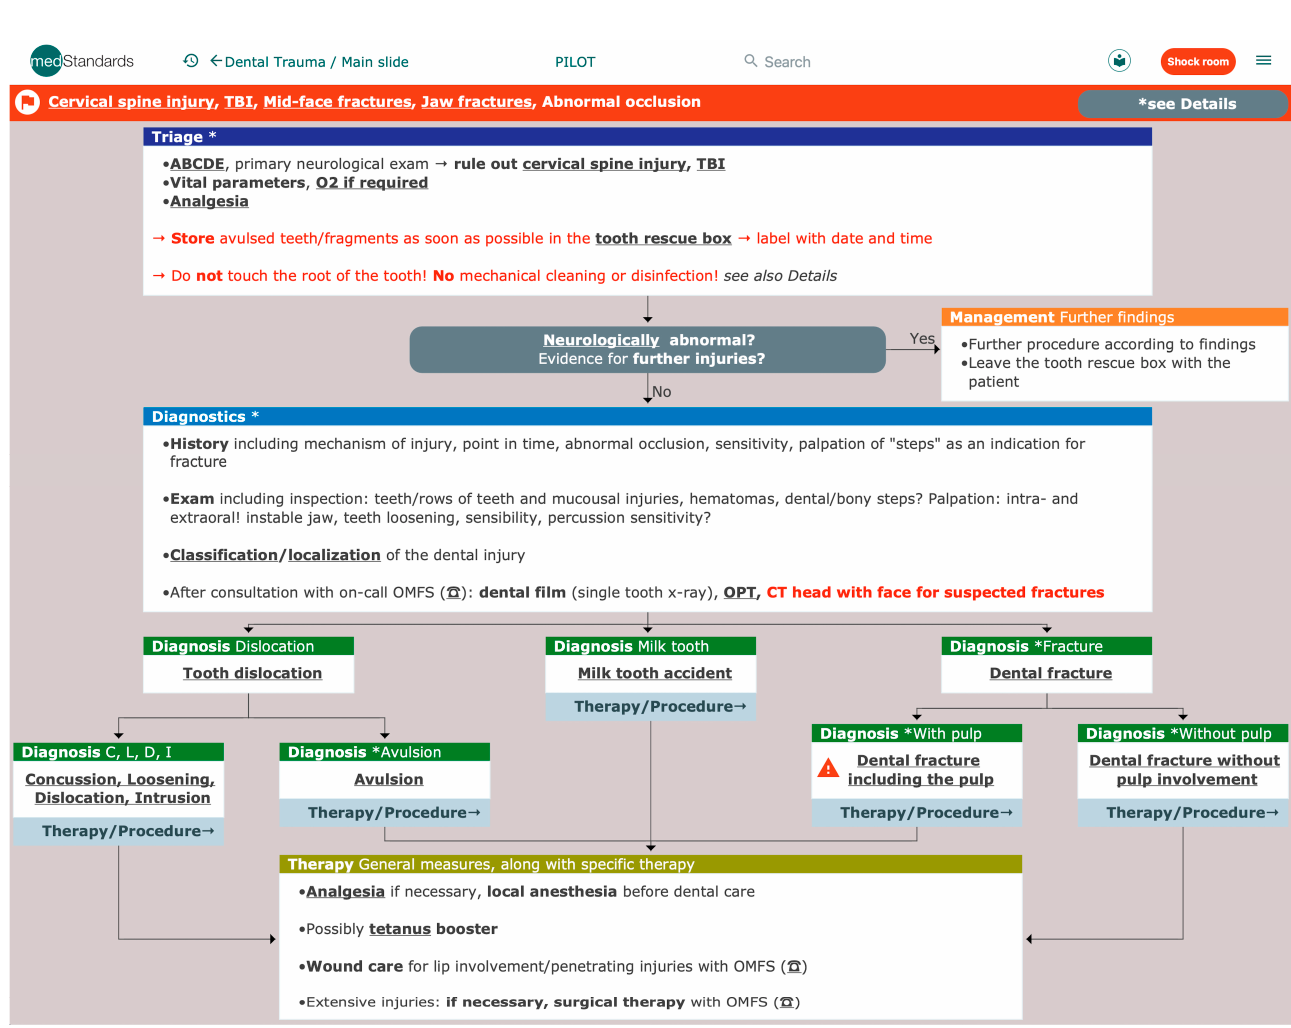
Figure 1. Screenshot ”medStandards” [16]—Dental Trauma. ABCDE: mnemonic for primary survey; TBI: traumatic brain injury; O 2 : oxygen; OPT: orthopantomogram; CT: computed tomography; OMFS: oral and maxillofacial surgeon.